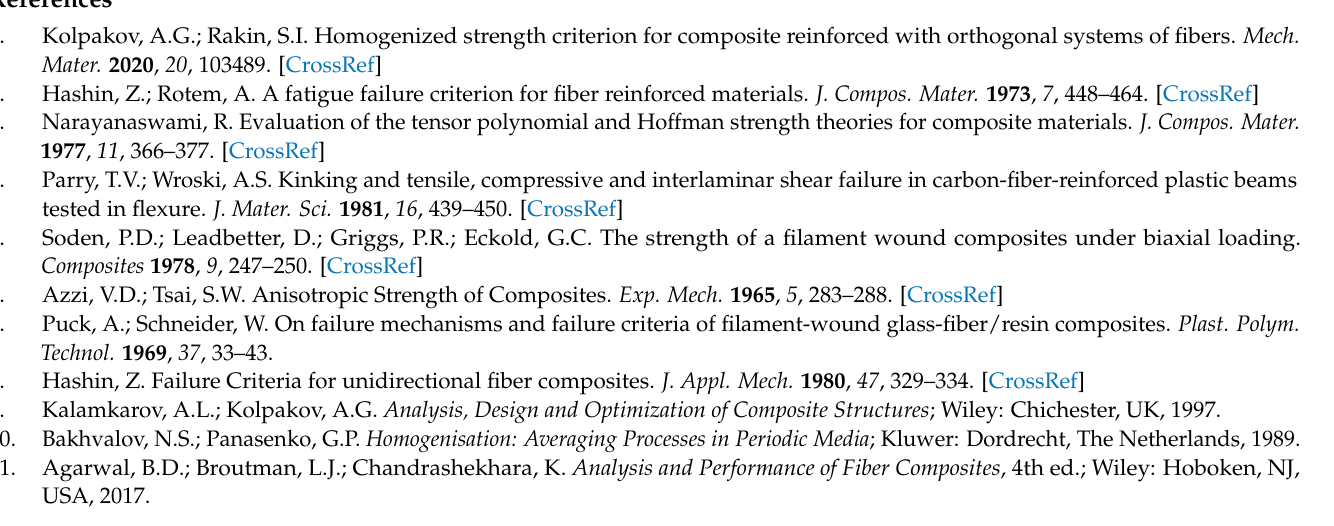
Figure 6. The failure surfaces when the epoxy strength limit σ ∗ = Pa.